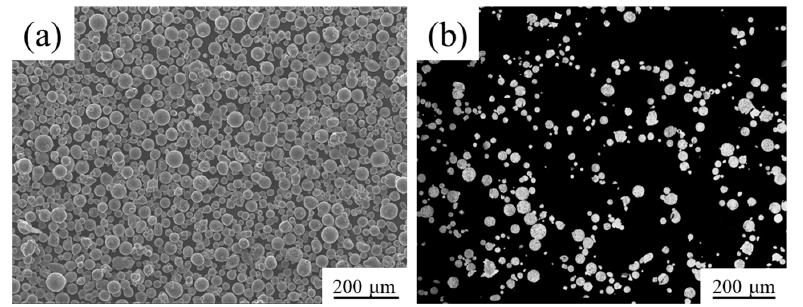
Figure 1. The morphology and cross-sectional microstructure of AlSi10Mg powder: ( a ) powder morphology; ( b ) cross-sectional microstructure.